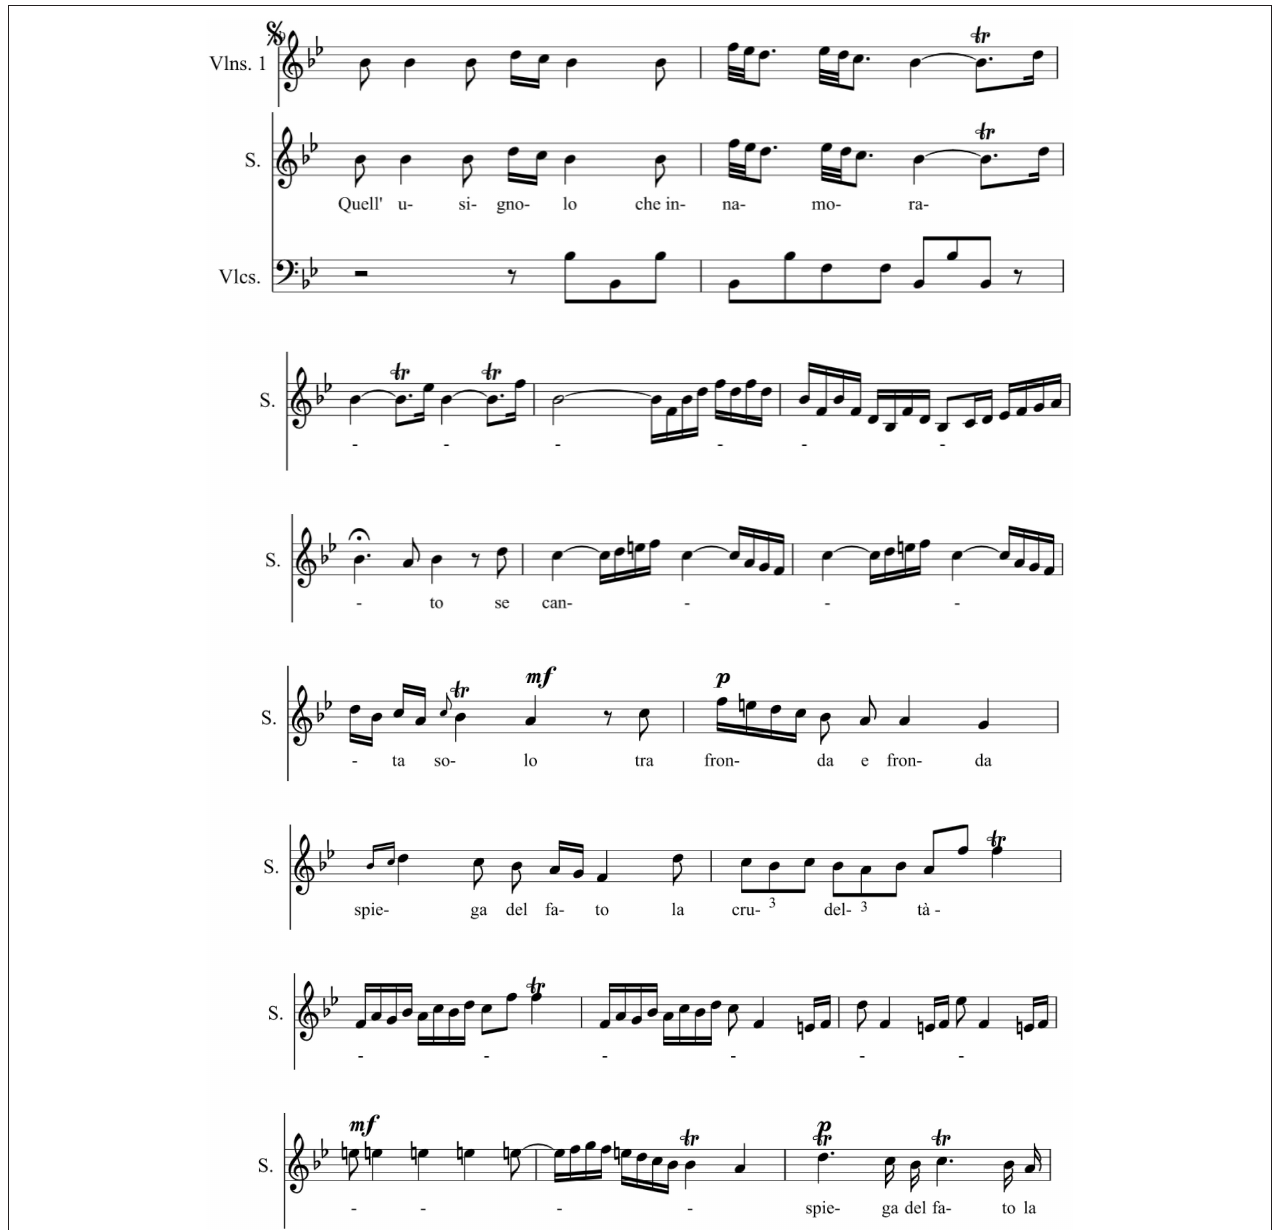
FIGURE 1 | Extract from the aria Quell’ usignolo of Geminiano Giacomelli’s (1692-1740) opera Merope (1734) sung by Carlo Broschi Farinelli (1705-1782) for Philipp V (1683-1746), king of Spain (Haböck, 1923). Reprinted with permission from Haböck (1923) © 1923 Universal Edition.